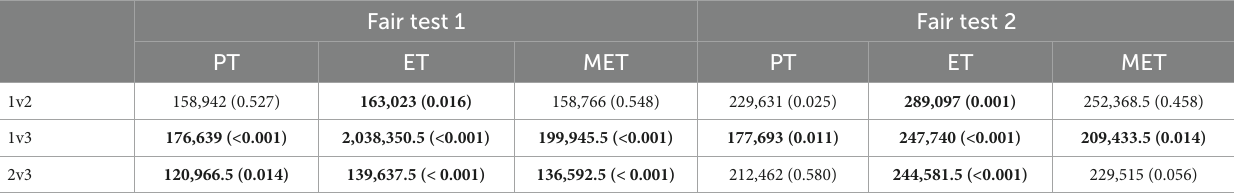
TABLE 5 Wilcoxon signed-rank test results between pair-wised score groups of the two fair